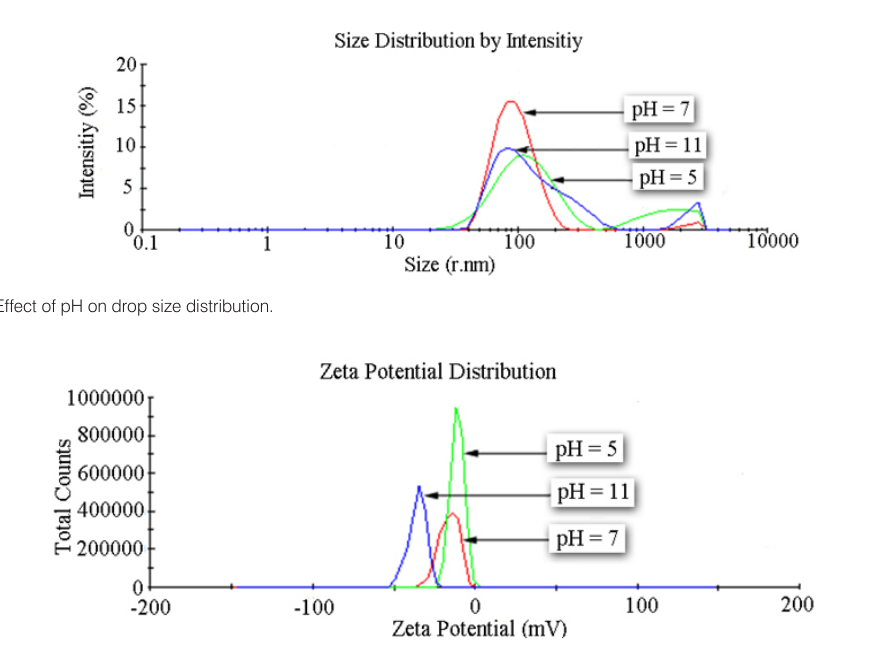
Figure 6. Effect of pH on zeta potential distribution of oil drops.